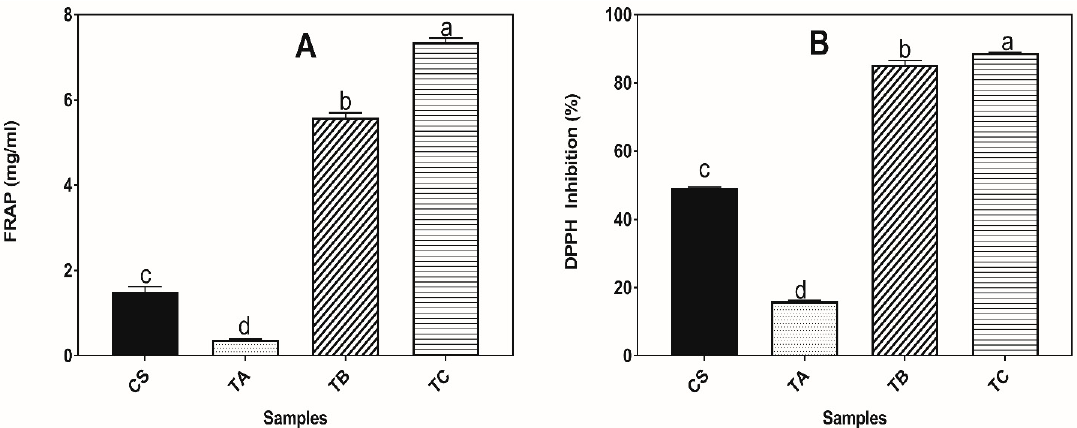
Figure 2. Percentage (mean ± standard deviation, n = 3) of antioxidant activities – ( A ) FRAP and ( B ) DPPH of the smoothies. Bars with different letters indicate values that are significantly different ( p < 0.05). CS: 45% Pineapple, 40% Banana, 15% Apple; TA: 44.5% Pineapple, 39.5% Banana, 14.5% Apple, 1.5% Moringa leaves; TB: 44% Pineapple, 39% Banana, 14% Apple, 3% Moringa leaves; TC: 43.5% Pineapple, 38.5% Banana, 13.5% Apple, 4.5% Moringa leaves. Table 4. Sensory evaluation of the smoothies supplemented with Moringa leaves.